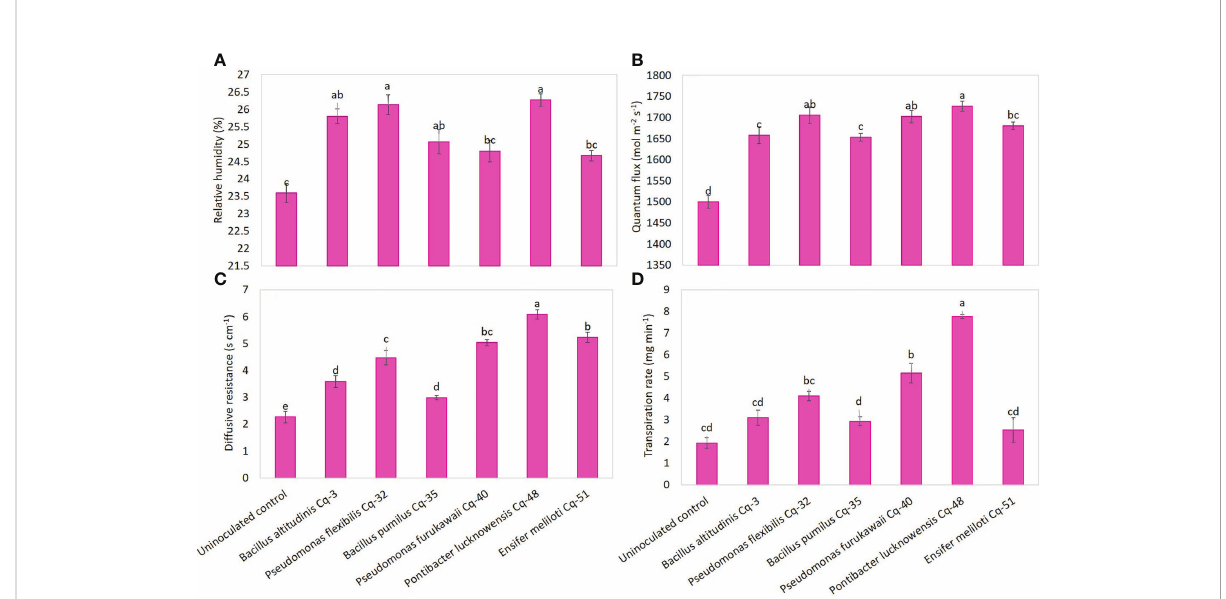
FIGURE 4 Effect of phosphate-solubilizing bacterial strains on quinoa physiological attributes in fi eld conditions; the physiological characteristics were recorded in terms of relative humidity (A) , quantum fl ux (B) , diffusive resistance (C) , and transpiration rate (D) ; the control had no inoculum (uninoculated control) and contains only broth; data presented are the mean of three replications along with standard error; the means sharing common letters were considered statistical similar to each other, and least signi fi cant difference (LSD) test was performed at 5% ( P ≤ 0.05) probability level.